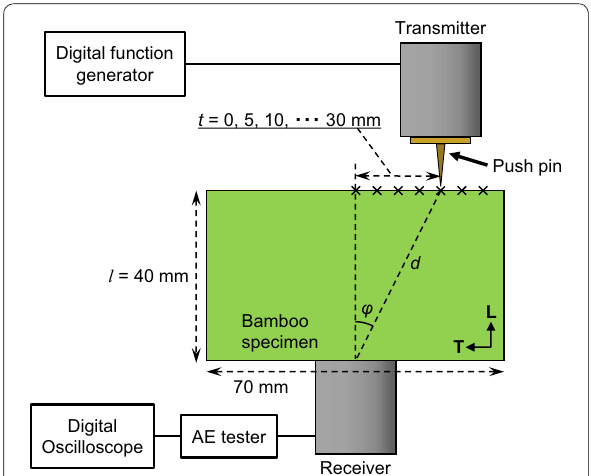
Fig. 3 Outline of the measurement system for attenuation of elastic waves when the length ( l ) of the bamboo specimen was 40 mm. Elastic waves were input at seven points ( ). The same procedure × was repeated three times after the bamboo specimen was shortened by 10 mm each time ( l 30, 20, 10 =